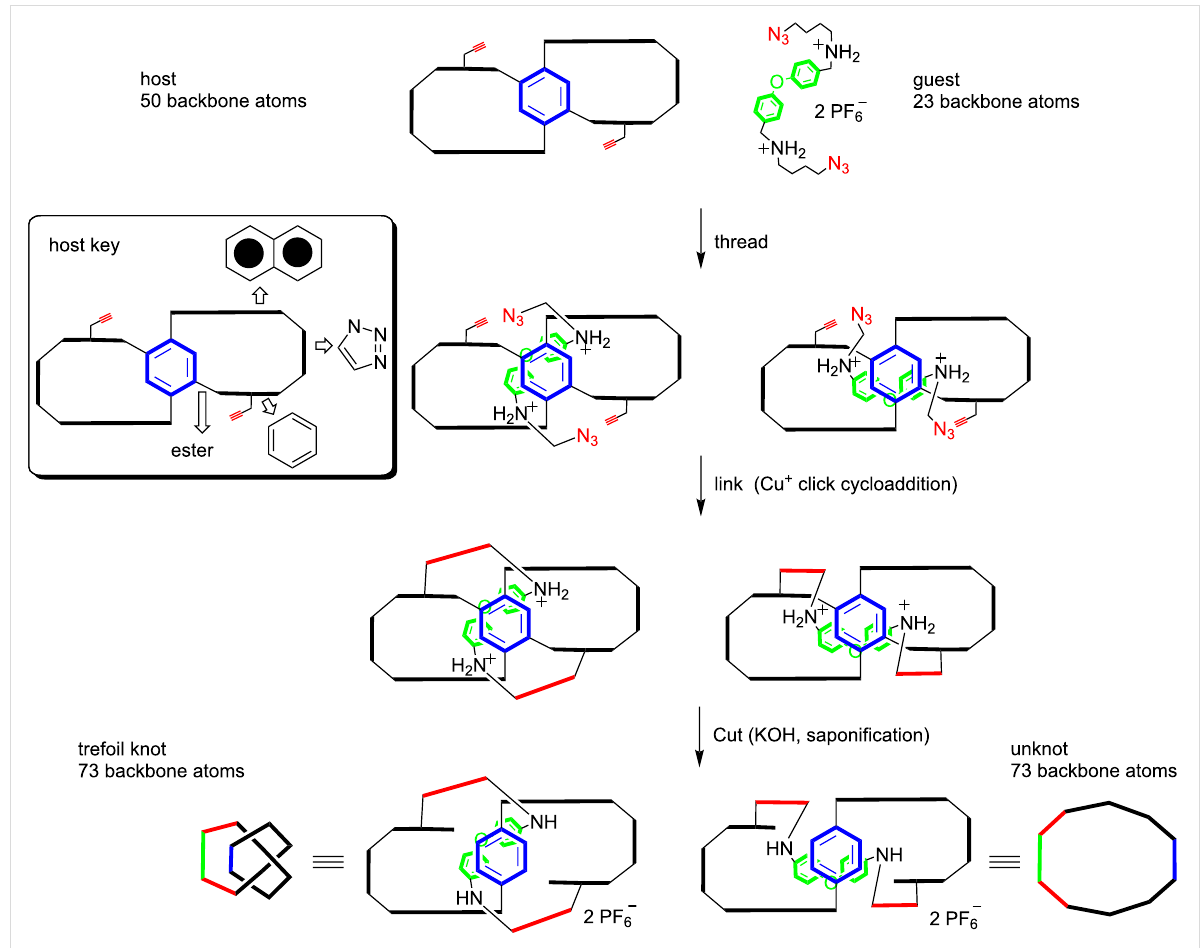
Figure 3: Schematic representation of the second-generation TLC approach to a 73 backbone atom trefoil